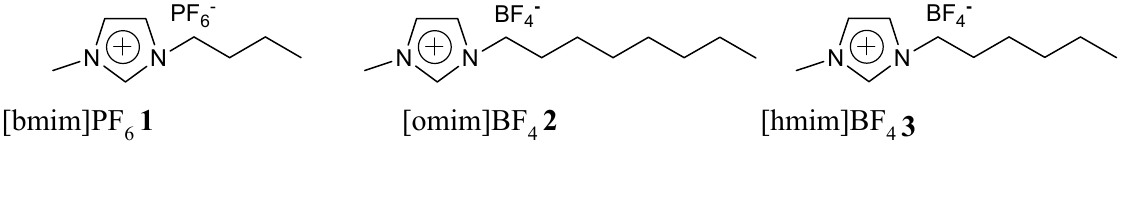
Figure 1. Structure of ionic liquids 1 -